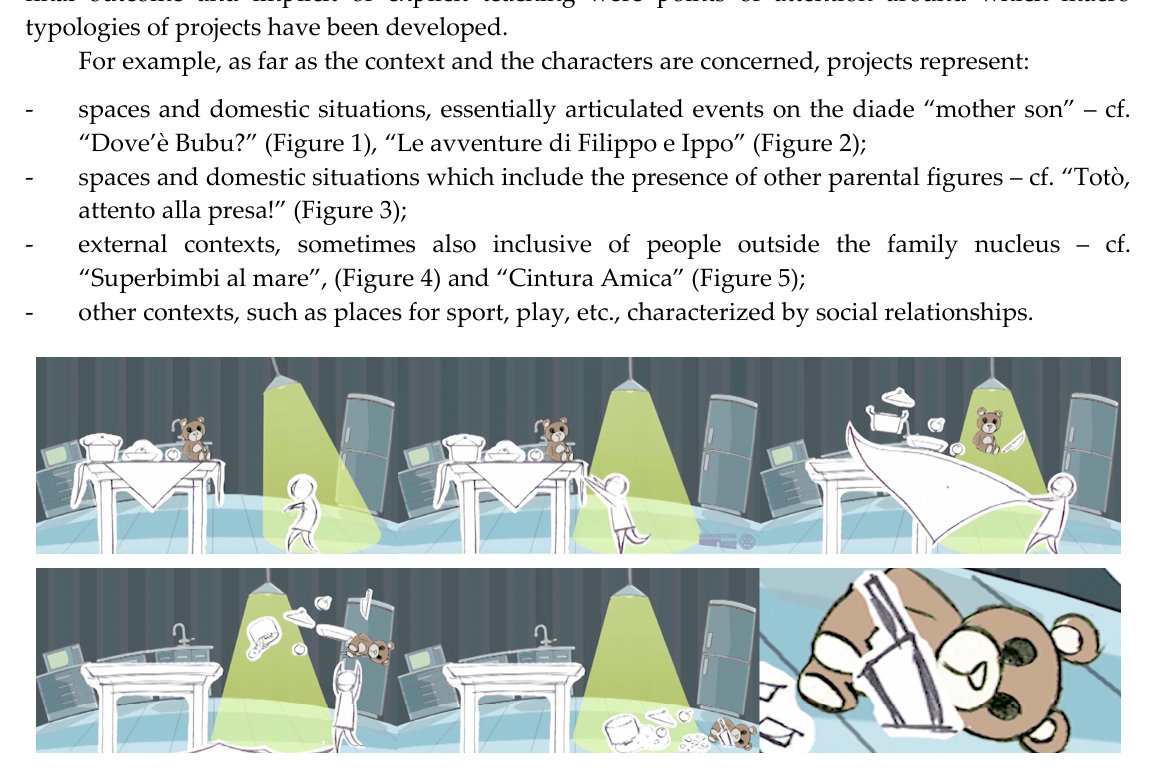
Figure 1. Frames from the project “Dov’è Bubu”. Problem: “home incident” (unassisted child activity, in areas at risk). Target: children 3–5 years and parents. Technique: animation; duration 30 s. Visual column: single fixed viewpoint, use of zoom for focalization. Soundtrack: Music base and, in relation to final frames, “voice over” to expose the message. Authors: Y. Bebei, A. Lolo, E. Spinelli, H. Tianmu, H. Xiaoyu. Credits in note 3